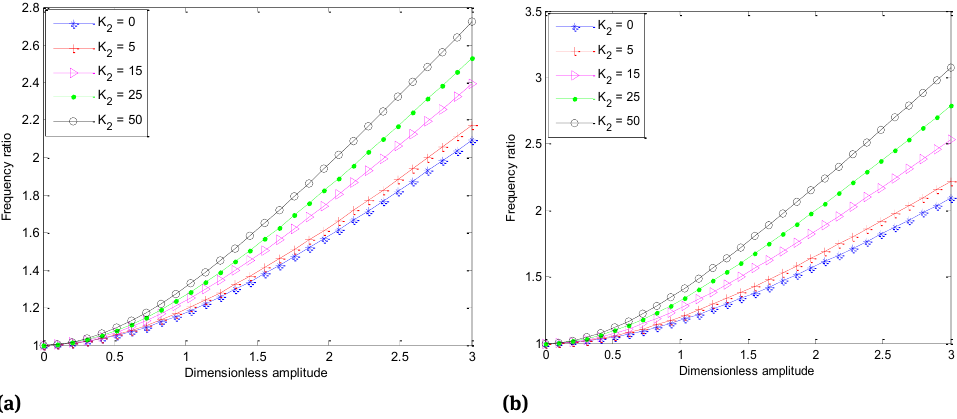
Figure 8: (a) Effects of dimensionless cubic nonlinear elastic medium stiffness on the frequency ratio for simply supported nanobeam (b) Effects of dimensionless cubic elastic medium stiffness on the frequency ratio for clamped-clamped supported